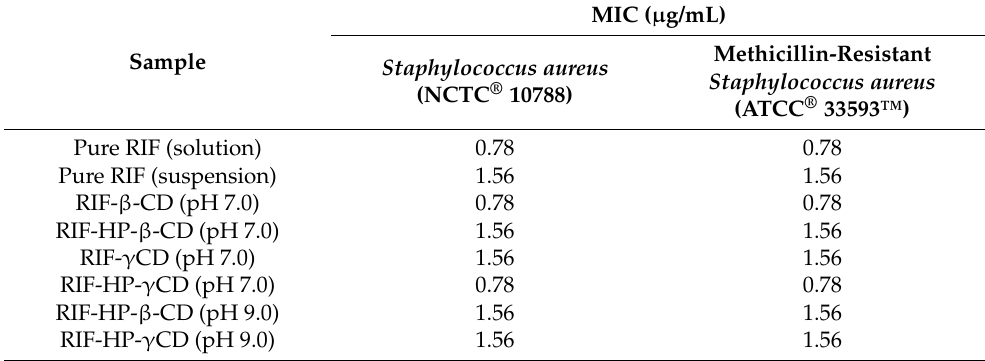
Table 2. MIC values of pure RIF and RIF-CD complexes ( n =